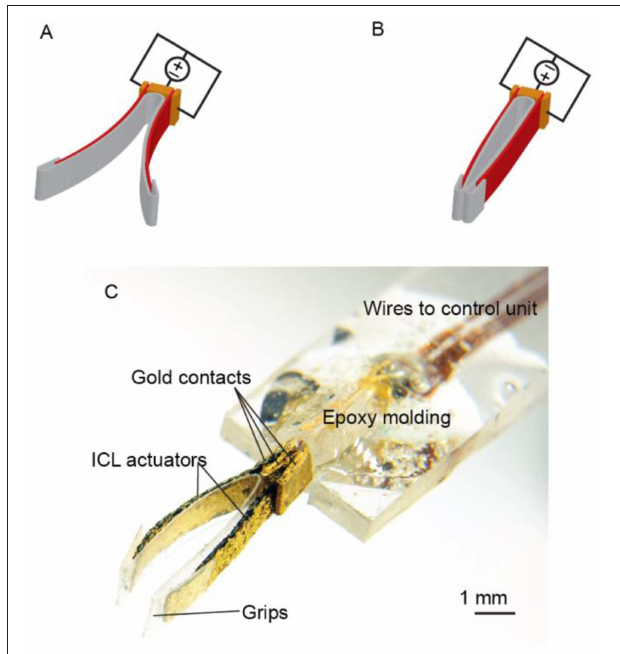
FIGURE 3 | Electroactive tweezers based on ICL actuators. (A,B) Tweezers in the open and closed positions, respectively. (C) Photograph of the final